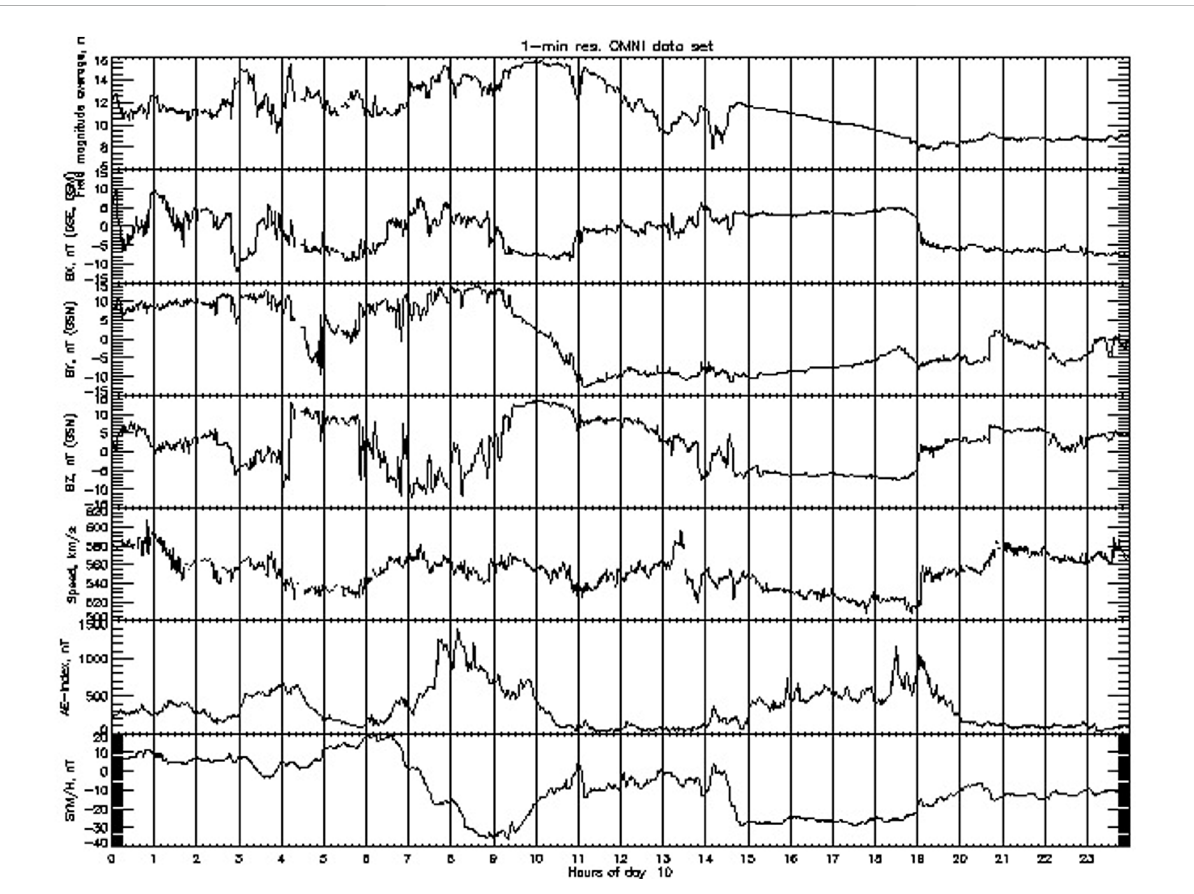
FIGURE 14 Data from the NASA OMNI website showing features of the interplanetary fi eld and fl ow, and, in the bottom two panels, the substorm auroral electojet (AE) index and the storm-time Sym-H index. Interplanetary data are delayed to the magnetopause. At 11 UT, the time of arrival of the CS structure, both geomagnetic indices indicate very quiet conditions. Substorms appear a few hours before and after 11